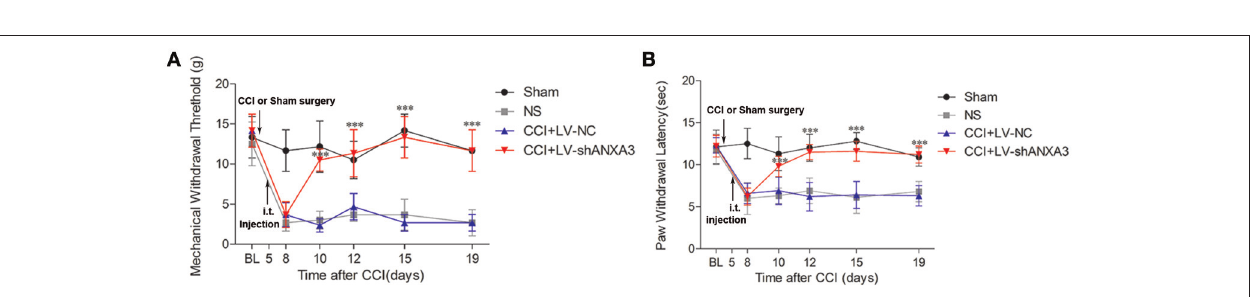
Frontiers in Neuroscience |